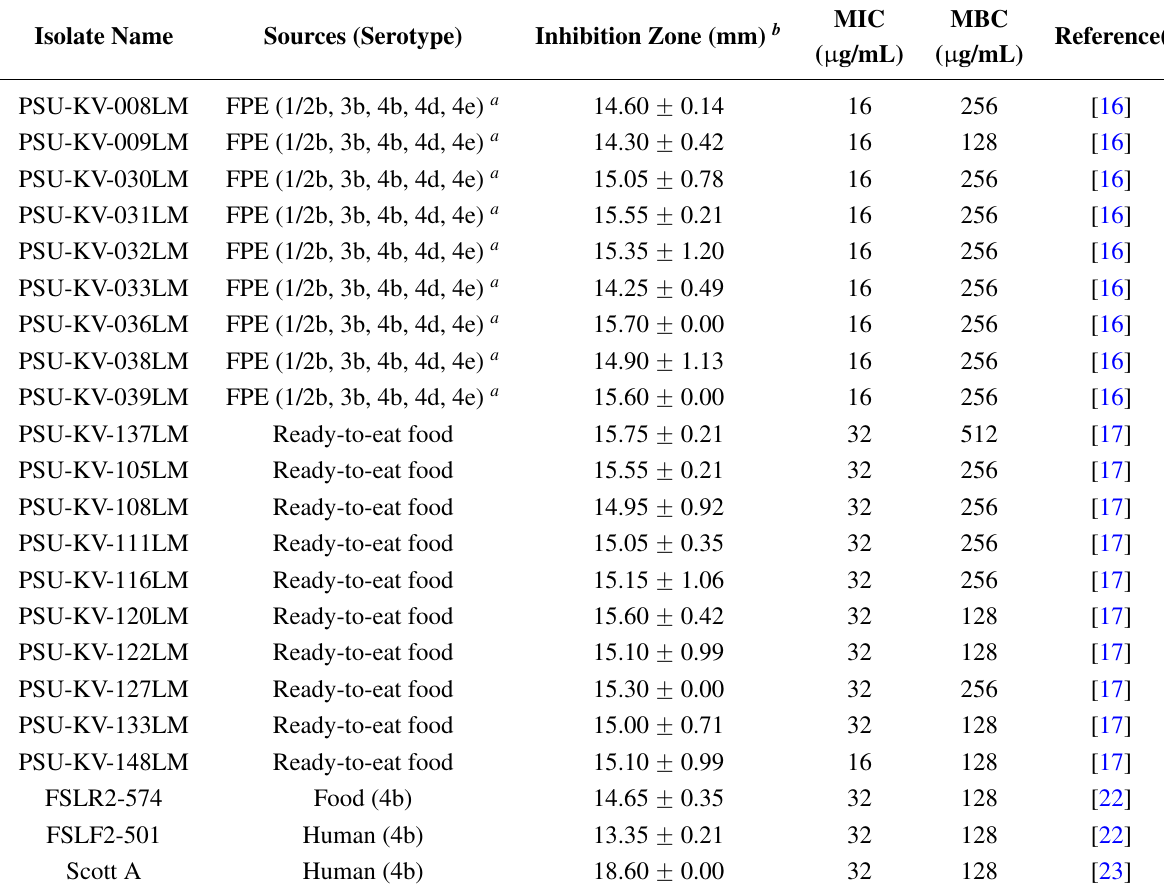
a Serotypes classified by multiplex-PCR; (FPE) is food processing plant environments; b Values are the mean ˘ duplicate determinations from treatment with the extract at a concentration of 2.5